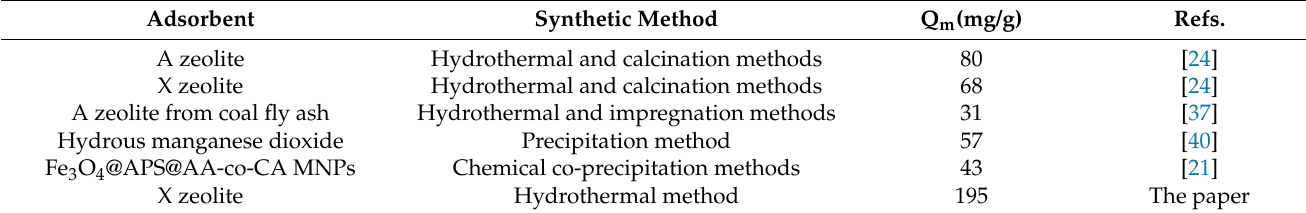
Table 7. Comparison of adsorption capacities of various adsorbents for Zn 2+